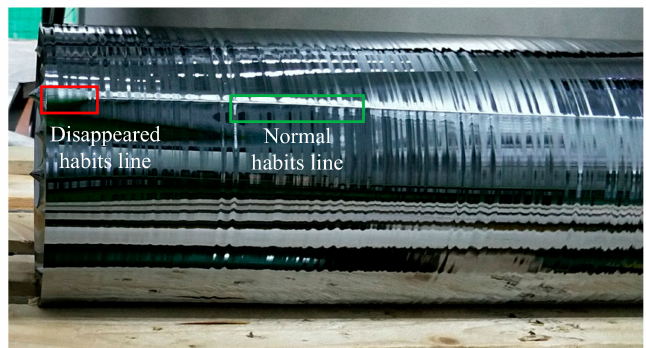
Figure 2. A finished silicon crystal ingot with a disappeared habit